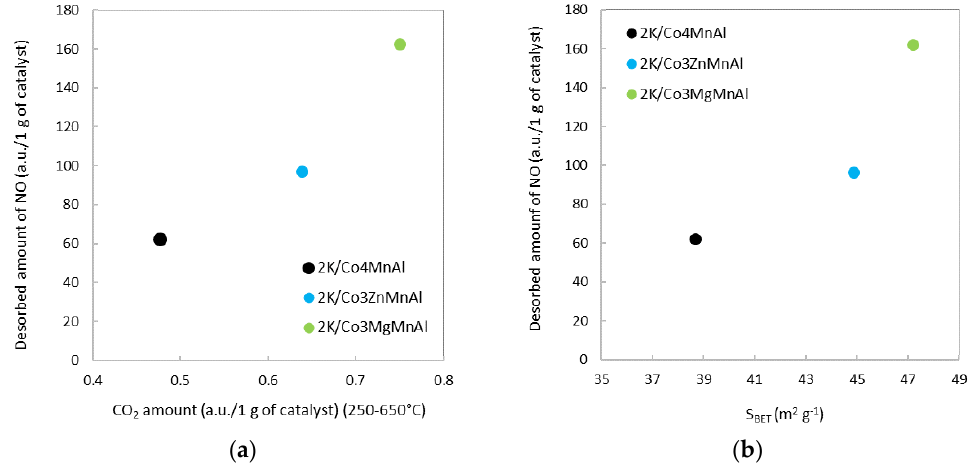
Figure 13. Dependence of desorbed NO amount from TPD-NO per weight of catalyst on ( a ) desorbed CO 2 from TPD-CO 2 and ( b ) specific surface area.